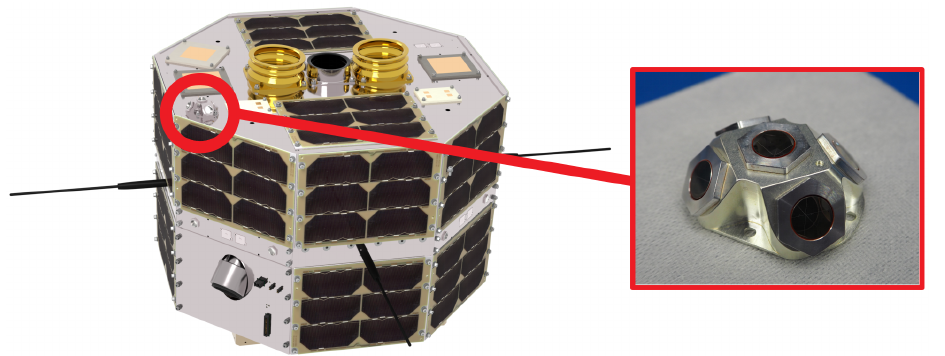
Figure 1. ( Left ) Representation of the TUBIN spacecraft in flight configuration. ( Right ) Retroreflector pyramid as it was mounted on nadir and zenith sides.